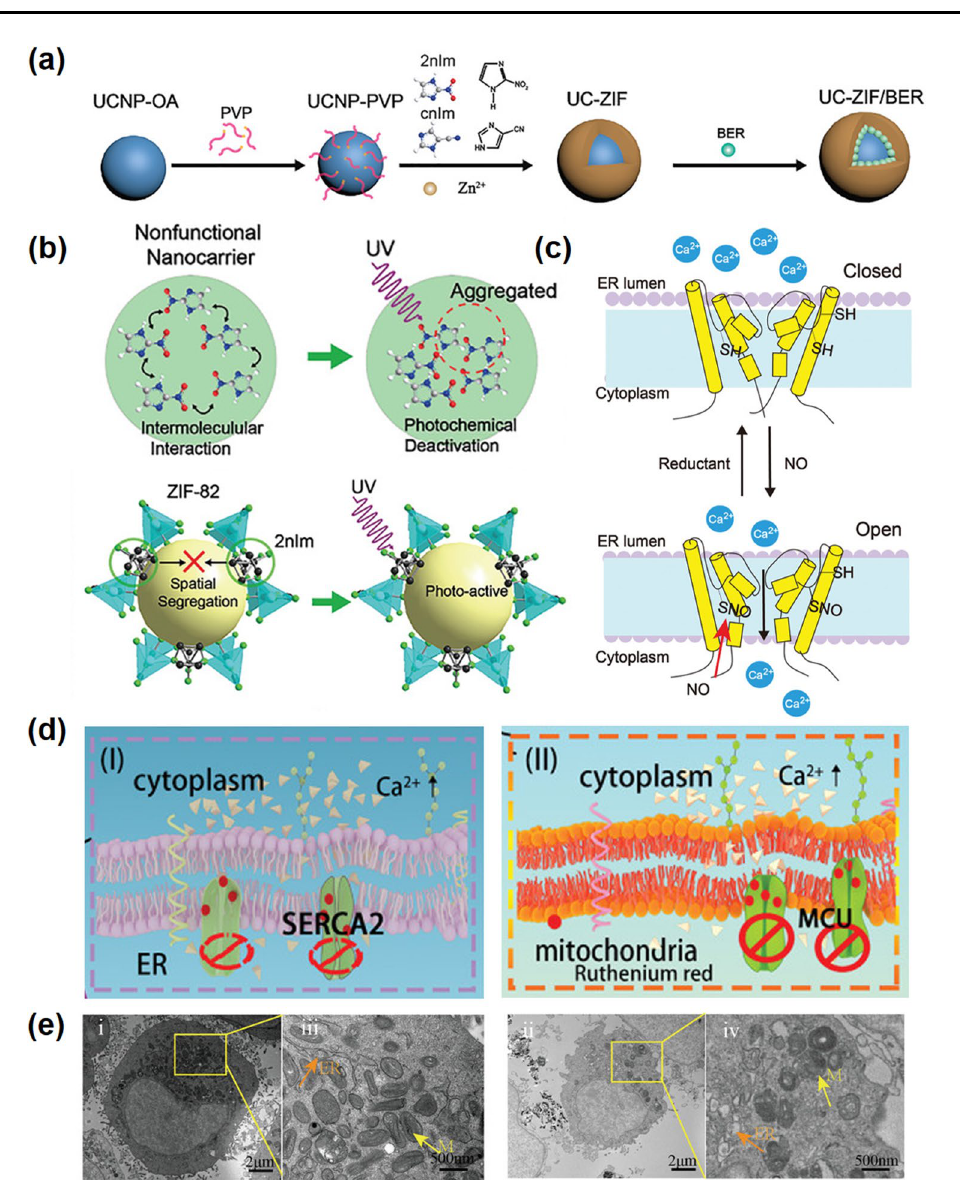
Fig. 9 Calcium channels and calcium pumps. a Synthetic process of UC-ZIF/BER. b Aggregation quenching mechanism of 2nIm molecules in nonfunctional carrier (top panel). ZIF-82 can improve photochemical activity of 2nIm molecules (low panel). c Illustration of RyRS activation by NO [138]. Copyright 2021, Wiley–VCH. d Ca 2+ channel proteins inhibitor ruthenium red inhibited the sarcoplasmic reticulum Ca 2+ -ATPase of endoplasmic reticulum (left panel) and the mitochondrial calcium uniporter of mitochondrial (right panel) to induce calcium overload. e The Bio-TEM image at 0 h (left panel) and 6 h (right panel) after UCRSPH + SA-CaO 2 NPS was incubated with 4T1 tumor cells for 5 min